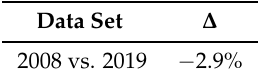
Table 5. Estimate of the performance change: 2008 vs. 2019 after gearbox replacement. (below rated power).